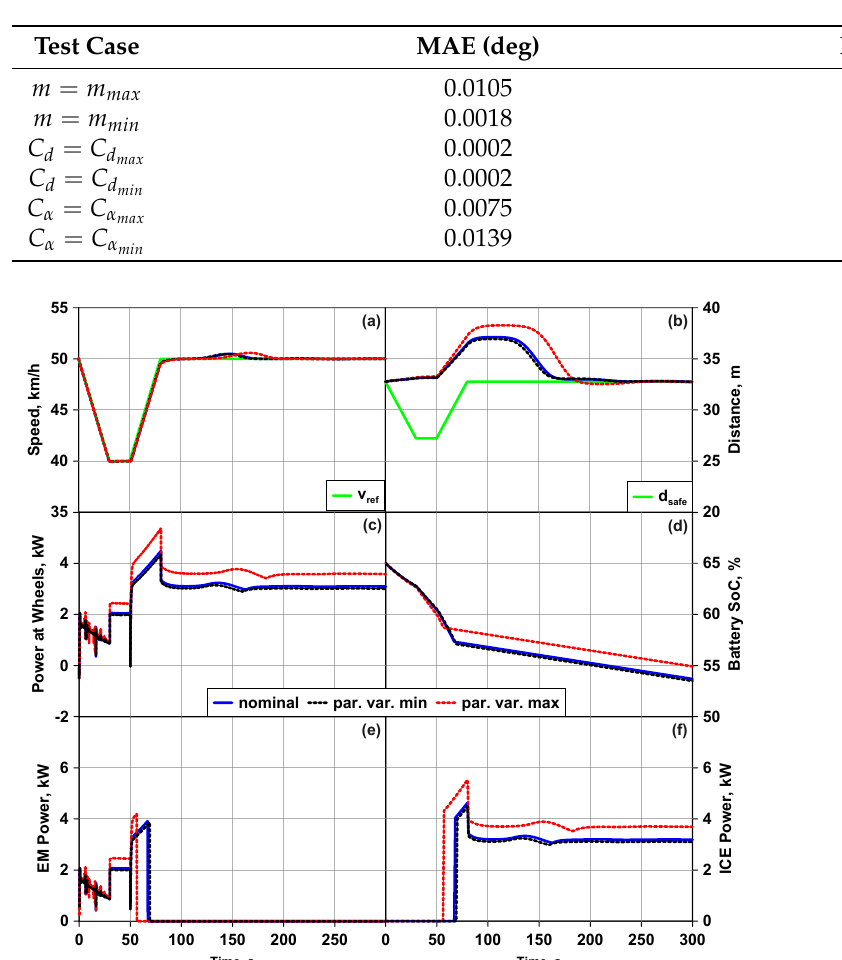
Table 13. MAE and RMSE for δ .